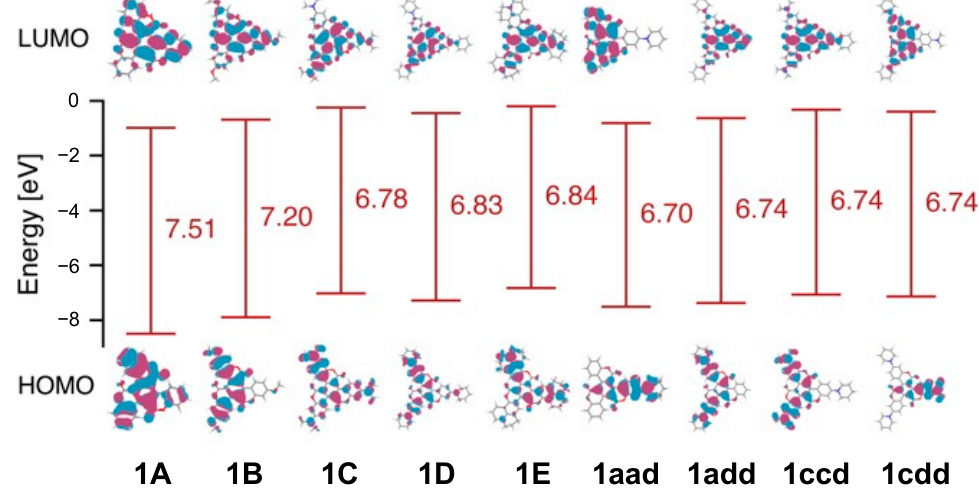
Figure 5. Highest occupied molecular orbitals (HOMOs) and lowest unoccupied molecular orbitals (LUMOs) of 1A , 1B , 1C , 1D , 1E , 1aad , 1add , 1ccd , and 1cdd , and corresponding HOMO-LUMO gaps energies estimated applying quantum chemical calculations.